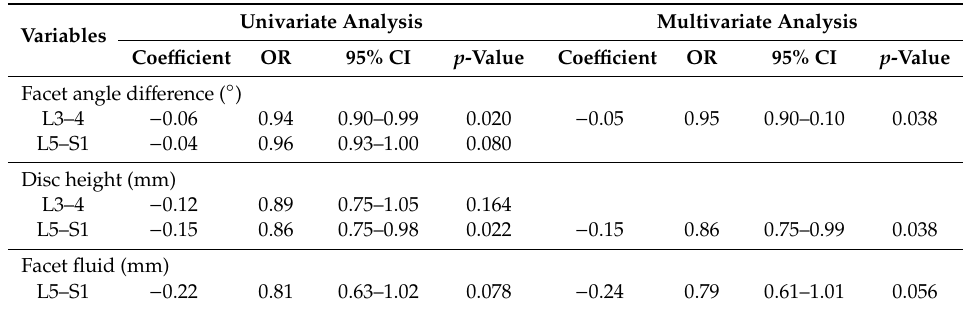
Table 3. Logistic regression analysis of factors associated with a positive response after a medial branch